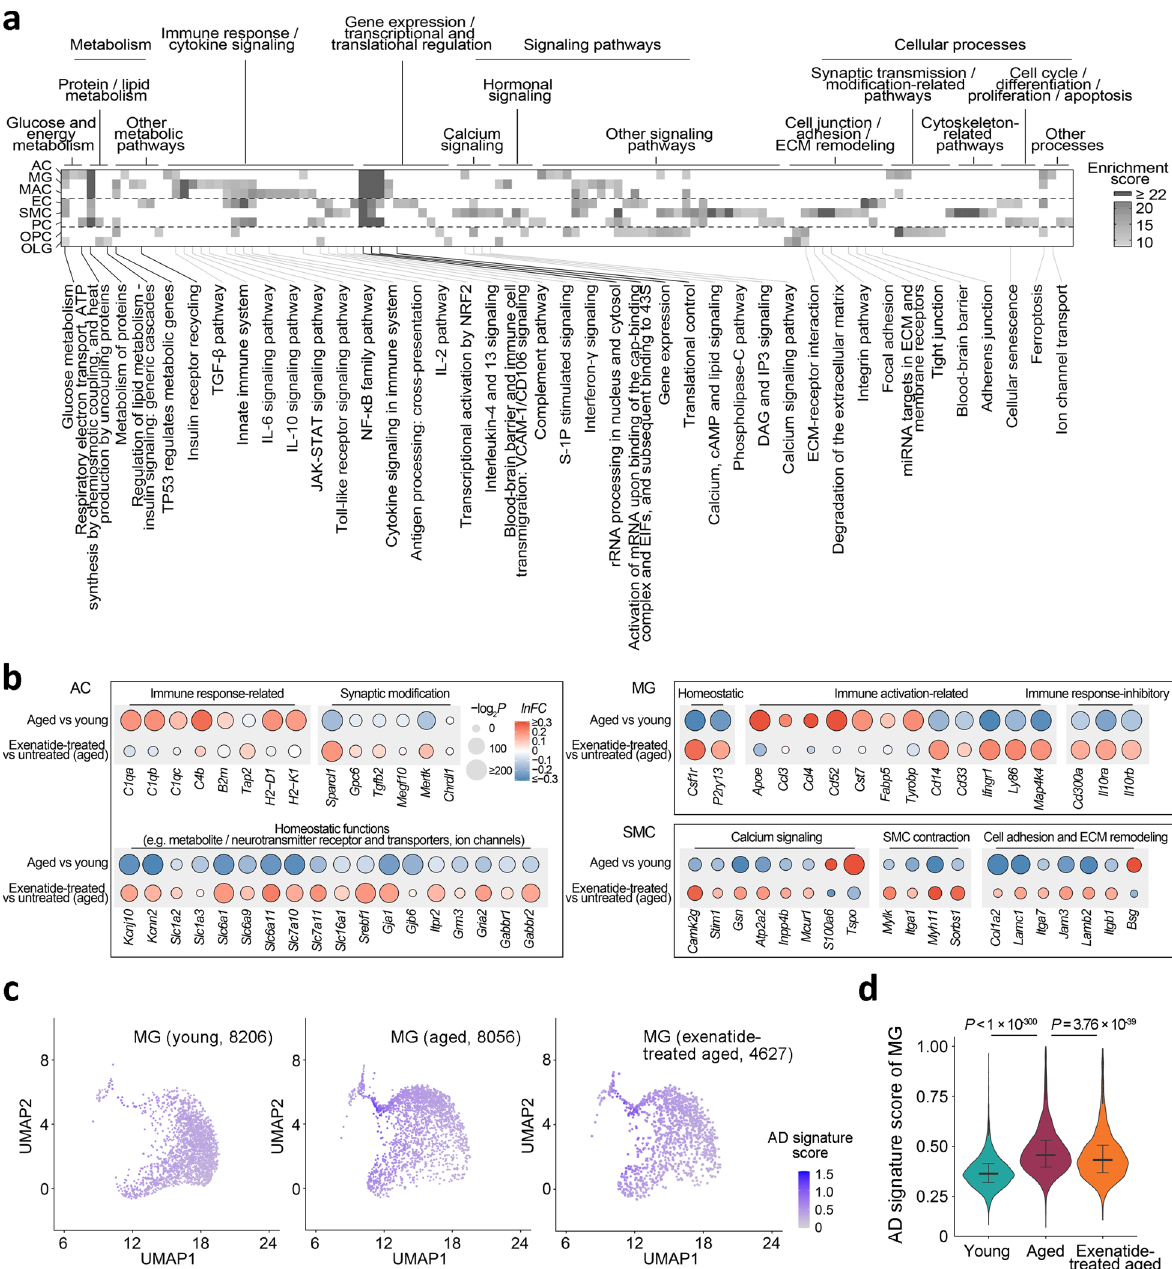
Fig. 2 Functional pathway analysis of the GLP-1RA treatment-reversed age-related transcriptomic changes. a Pathways with signi fi cant enrichment among the most prominent age-related expression changes reversed by exenatide treatment in the different cell types. b Dot plots of expression changes of selected functionally important genes in AC, MG, and SMC, in aging and post-exenatide treatment. c UMAP visualization and d violin plots of AD signature scores in the MGs from young adult, aged and exenatide-treated aged mouse brains. Numbers in brackets in c : cell numbers for the respective groups in the dataset. Horizontal lines in d represent medians (young adult, 0.36; aged, 0.46; exenatide-treated aged: 0.43), 25th and 75th percentiles. Comparison of Alzheimer ’ s disease (AD) signature scores in the MGs among the three groups: P = 2.2 × 10 − 16 , Kruskal – Wallis test; the P -values of pairwise comparisons by post hoc Dunn ’ s test are shown in d . Cell type abbreviations: same as in Fig. 1. See Supplementary Data 1 for source data underlying a and b